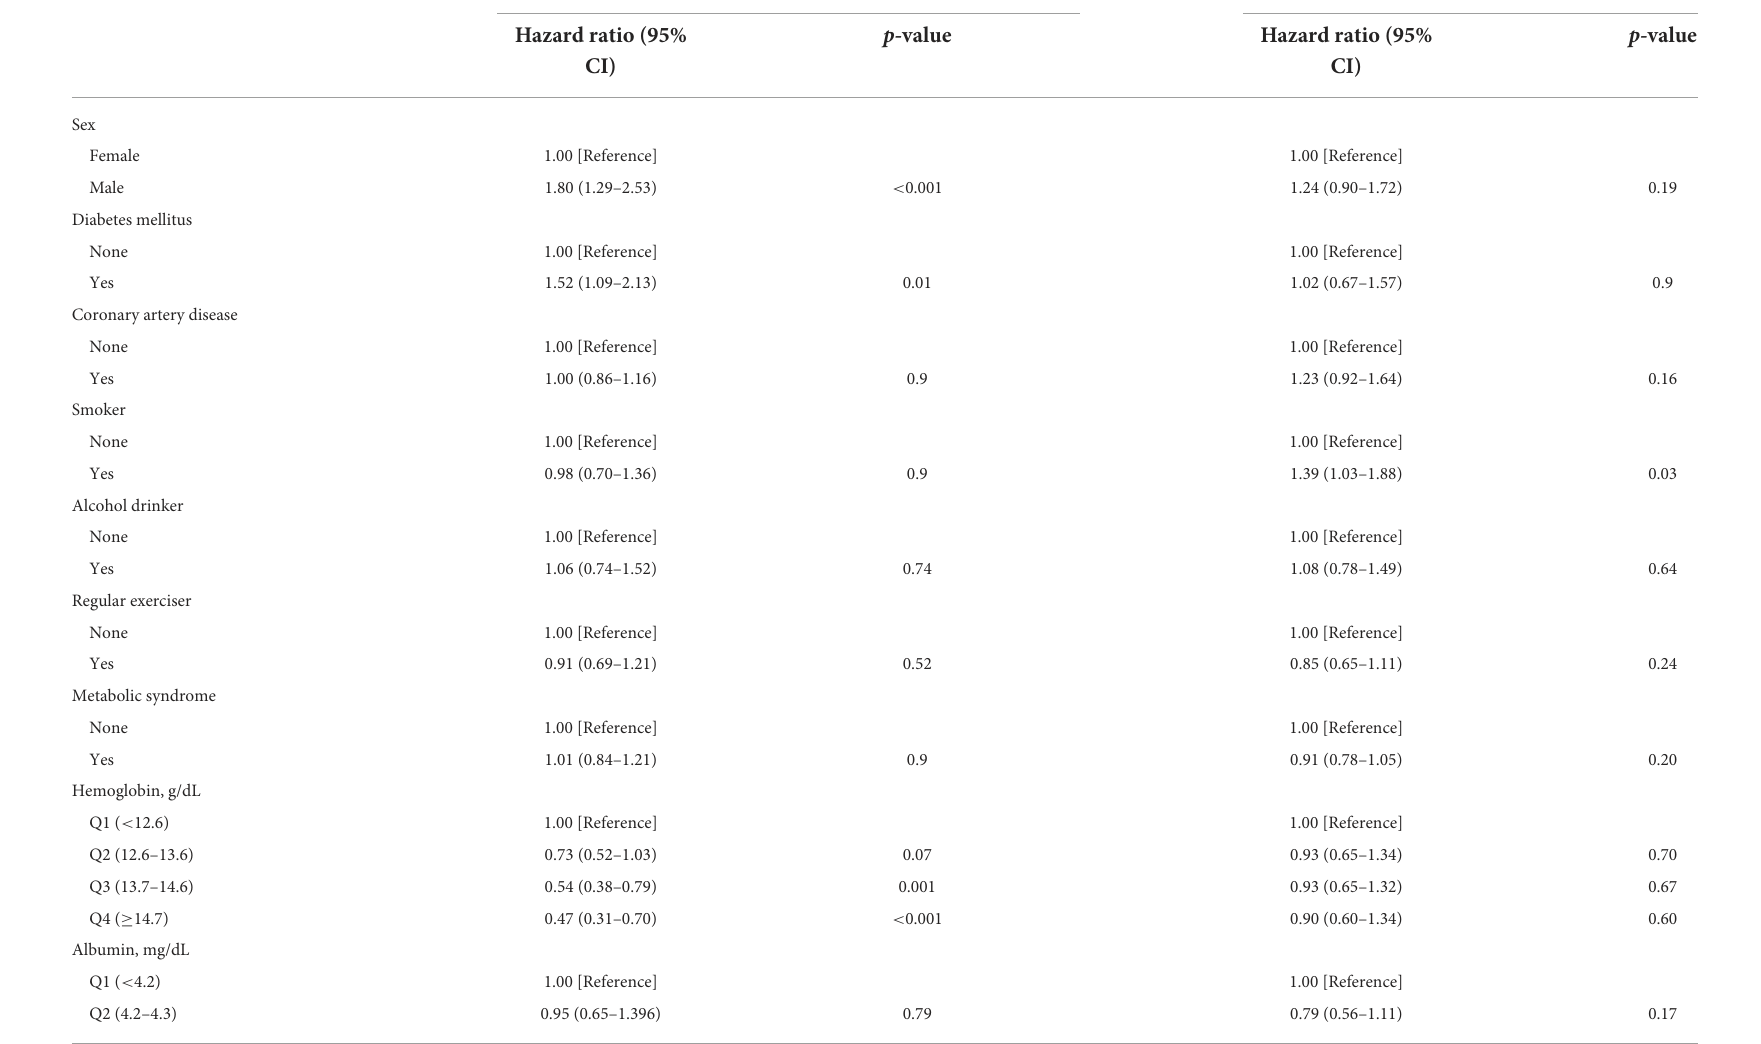
TABLE 3 Factors associated with transiting to estimated glomerular filtration rate (eGFR) < 30 mL/min/1.73 m 2 or death in the cohort with baseline eGFR 59–30 mL/min/1.73 m 2